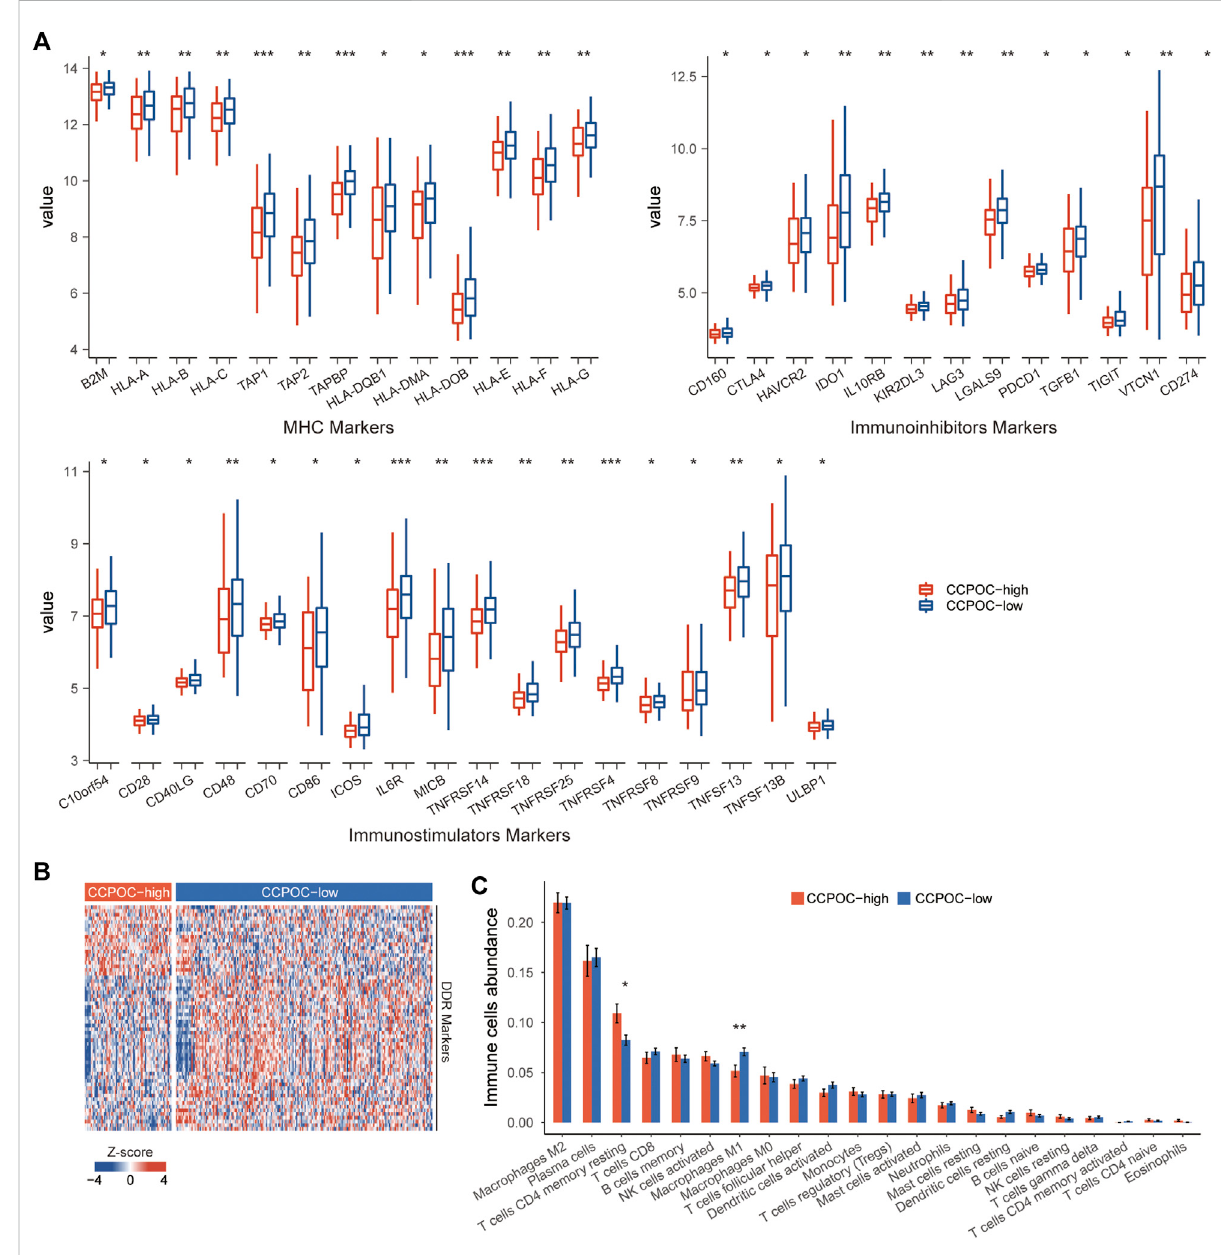
FIGURE 5 Immune microenvironment composition in CCPOC groups. (A) Expression levels of immuno-inhibitors, MHC I/II molecular, and immuno- stimulator markers within the CCPOC groups. (B) Heatmap of the expression of DDR markers between the CCPOC-high and CCPOC-low groups. (C) Distribution of 22 immune cells in the CCPOC groups. (* p < 0.05 and ** p <